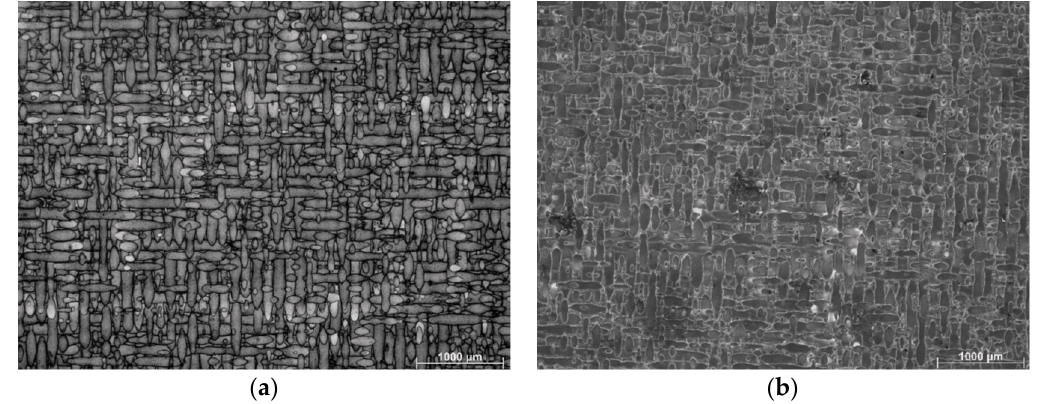
Figure 2. Microstructure of sample from light microscopy ( a ) SLM; ( b ) HT280.